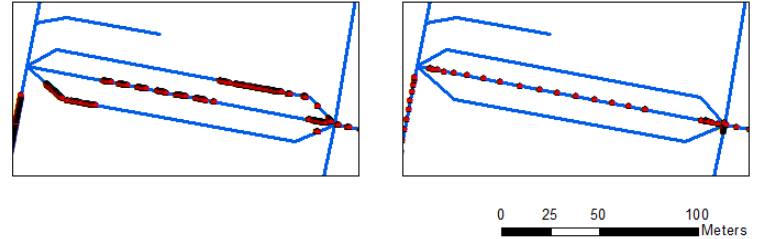
Figure 6. Details of point-to-curve ( Left ) and curve-to-curve ( Right ) map-matching results.